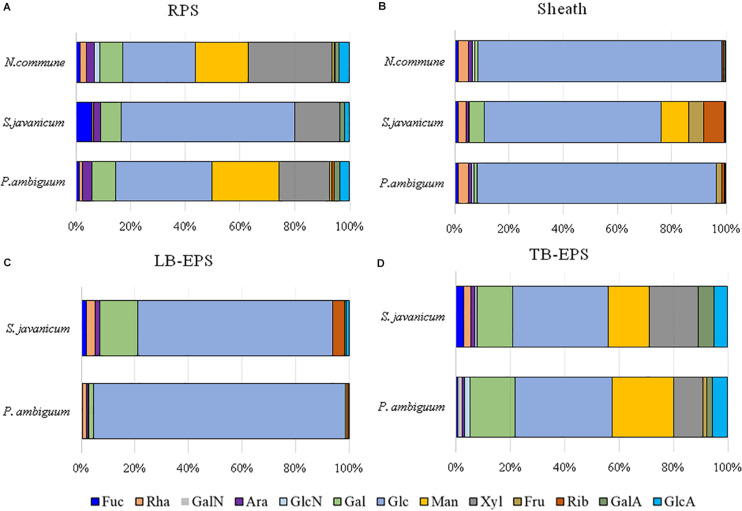
Monosaccharidic composition of the EPS extracted from liquid culture: (A) RPS, (B) sheath, and from sandy soil microcosms: (C) LB-EPS; (D) TB-EPS, of the cultured strains. Molar percentages (%) of single sugars are represented (expressed as moles of the single monosaccharide divided by the total amount of moles of monosaccharides in the EPS × 100). No data are reported for N. commune in the sandy soil microcosms (C,D) because of the negligible amounts of EPS extracted. Abbreviations: Fuc fucose, Rha rhamnose, GalN galactosamine, Ara arabinose, GlcN glucosamine, Gal galactose, Glc glucose, Man mannose, Xyl xylose, Fru fructose, Rib ribose, GalA galacturonic acid, GlcA glucuronic acid.